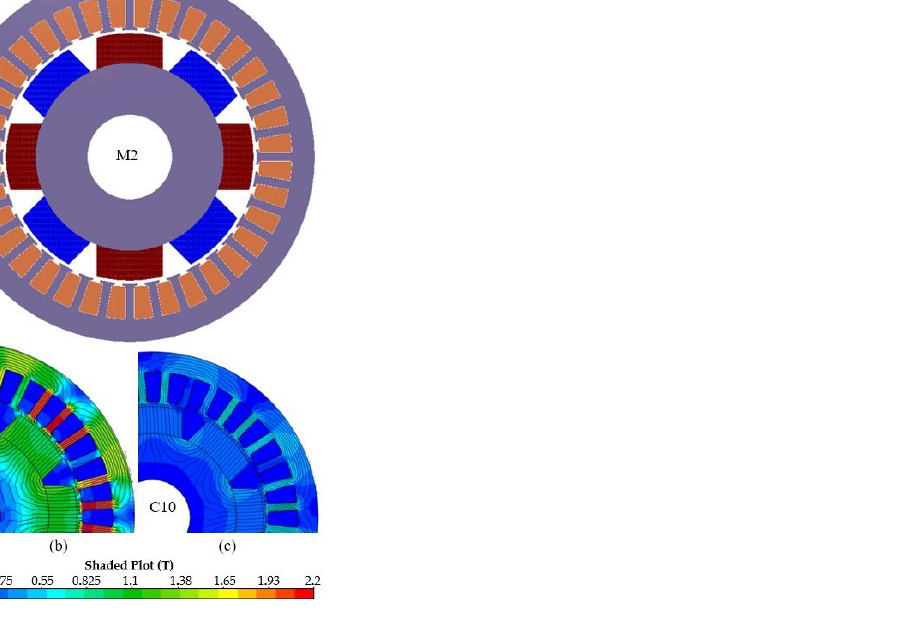
Figure 2. Radial machine: ( a ) general view, ( b ) magnetic flux density in the stator and rotor core of N42 PM machine, ( c ) magnetic flux density distribution in the stator and rotor core of C10 PM machines.